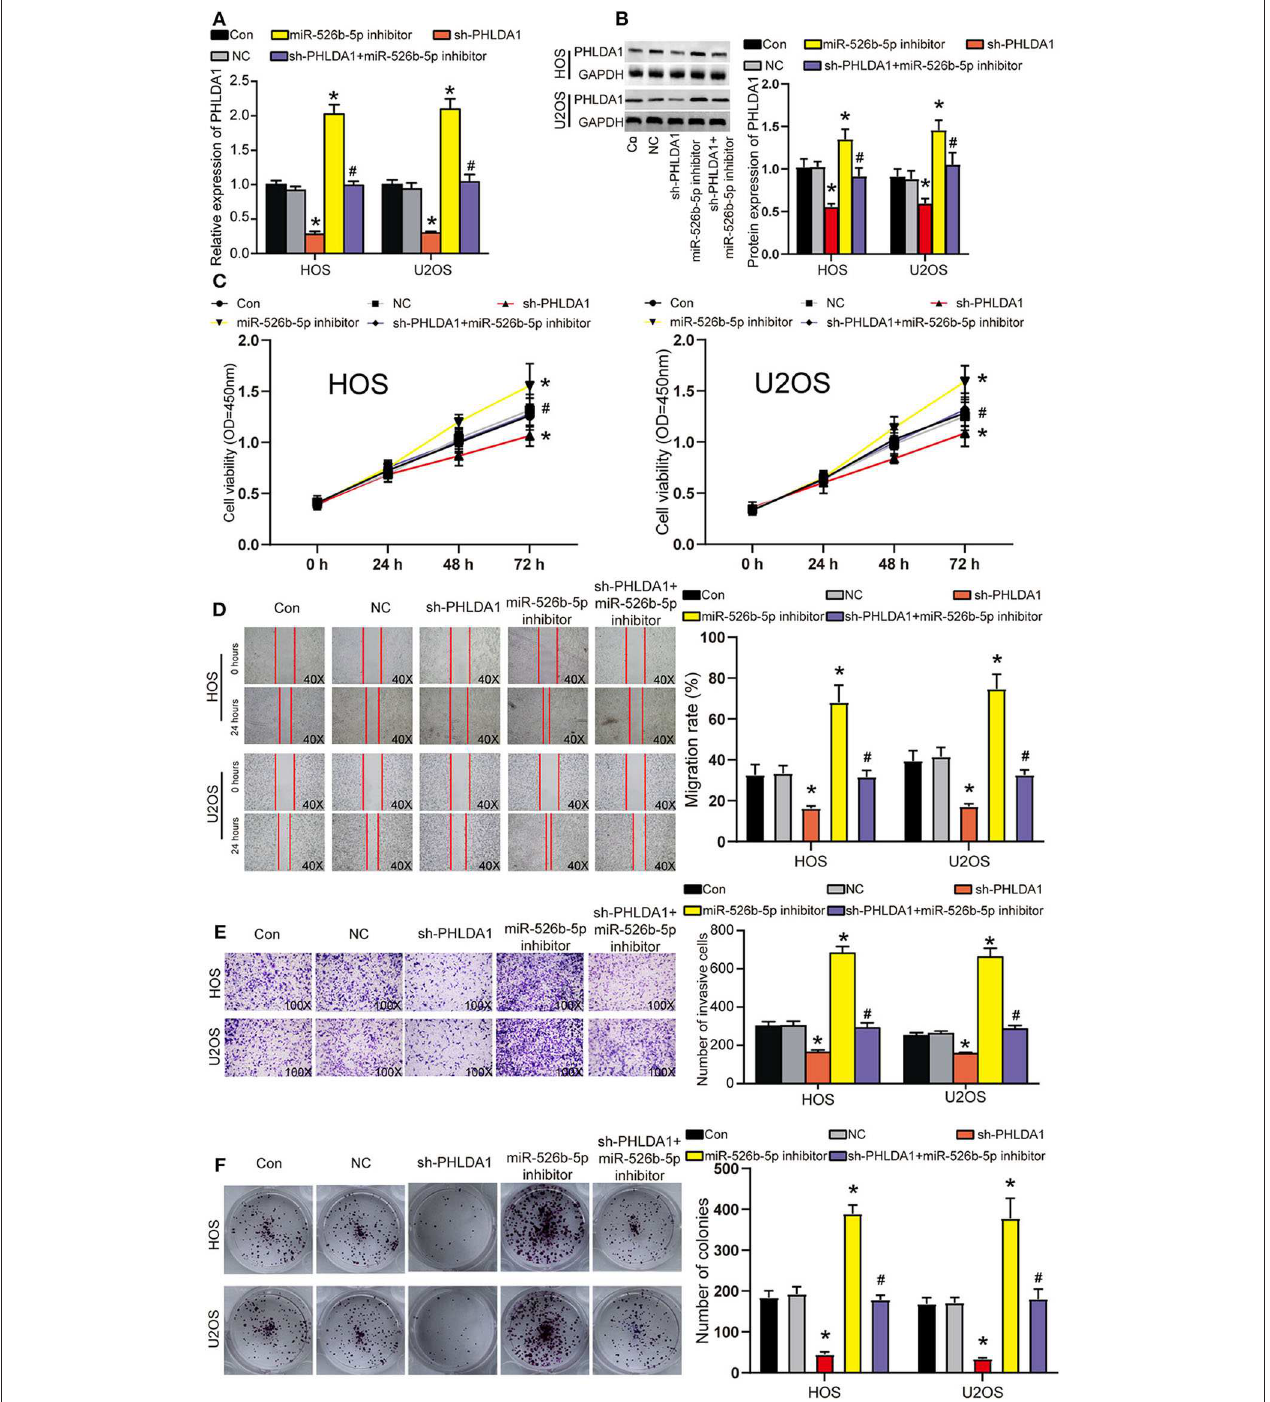
FIGURE 6 | miR-526b-5p inhibition resulted in enhanced the viability, migration, invasion, and proliferation of osteosarcoma (OS) cells in a pleckstrin homology-like domain family A member 1 (PHLDA1)-dependent way. (A) The transfection efficiency of sh-PHLDA1, miR-526b-5p inhibitor, and sh-PHLDA1 + miR-526b-5p inhibitor in HOS and U2OS cells was determined at messenger RNA (mRNA) level. (B) The transfection efficiency of sh-PHLDA1, miR-526b-5p inhibitor, and sh-PHLDA1 + miR-526b-5p inhibitor in HOS and U2OS cells was determined at protein level. (C) The cell viability of OS cells in the five groups was analyzed by CCK8 assay. (D) The migration ability of OS cells in the five groups was analyzed by wound healing assay. The migration rate of every group was interpreted. Magnification: 40 × . (E) The invasion ability of OS cells in the five groups was analyzed by Transwell assay. The invading cell number was counted in every selected field. Magnification: 100 × . (F) Cell proliferation was determined using colony formation assay. The colony number in every group was analyzed. Con, control; NC, negative control. * p < 0.05 vs. control. # p < 0.05 vs. sh-PHLDA1 group.